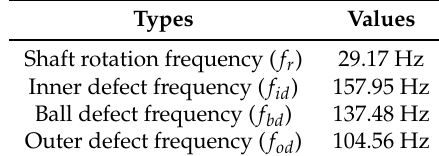
Table 3. Bearing defect frequencies under the rotating speed of 1750 rpm.